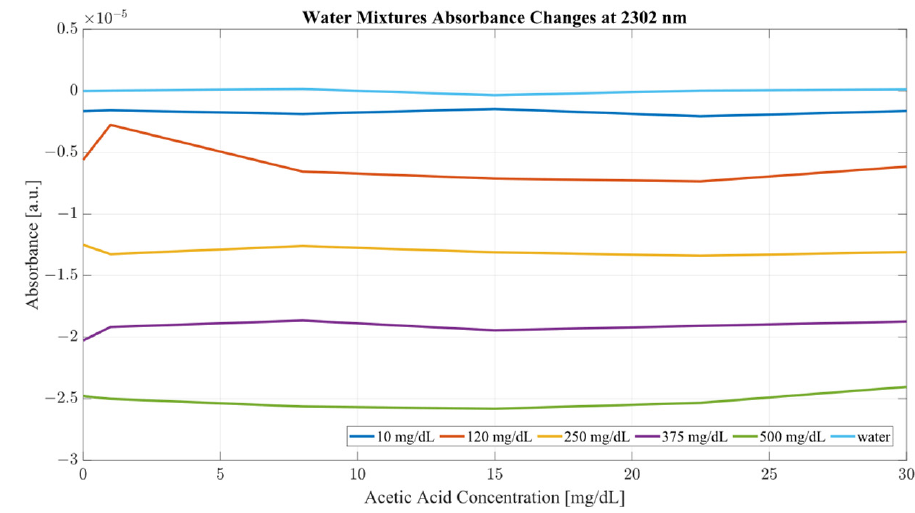
Figure 6. Water mixture absorbance changes at 2262 nm.